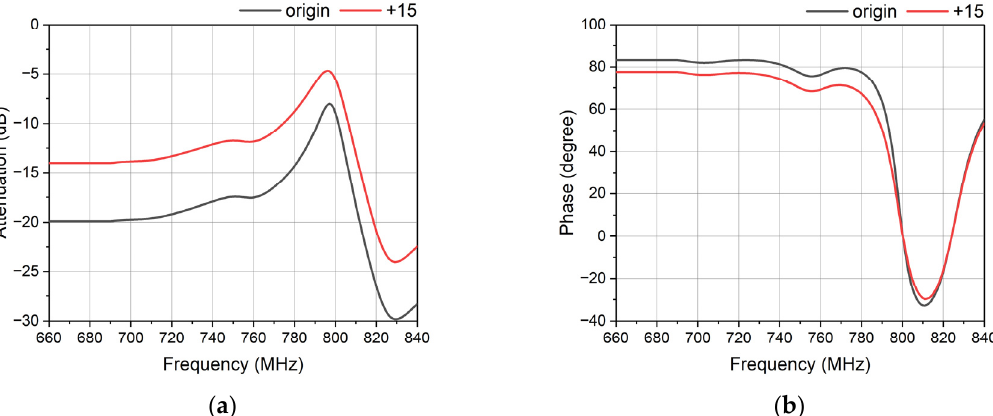
Figure 11. The response of the interdigital capacitor with different electrodes. The number of the electrodes of the black one is 15, and the number of electrodes of the red one is 30. ( a ) The attenuation of the different electrodes. ( b ) The phase of the different electrodes. Table 1. The parameters of the